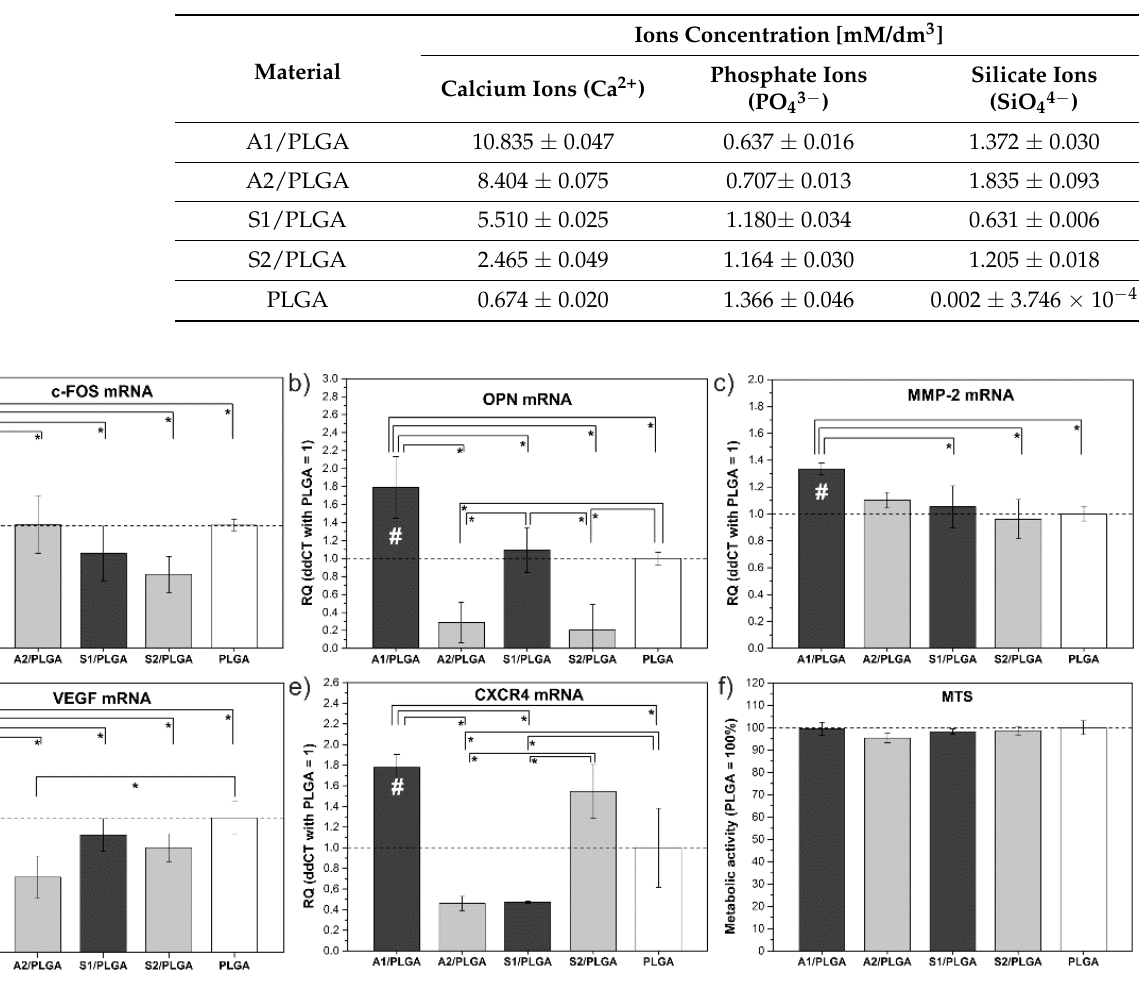
Figure 2. The mRNA levels of BMP-2 after 72-h BMSC treatment with CMs from studied composites ( a ); cell migration rate upon treatment with CMs ( b ); phospho-ERK 1/2 and total ERK 1/2 activation upon CM treatment ( c ). The results for control cells treated with CMs collected from PLGA are